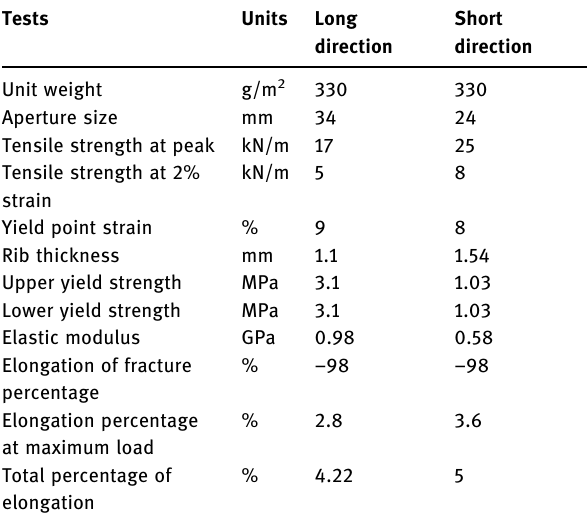
Table 5: Physical properties of the used geotextile